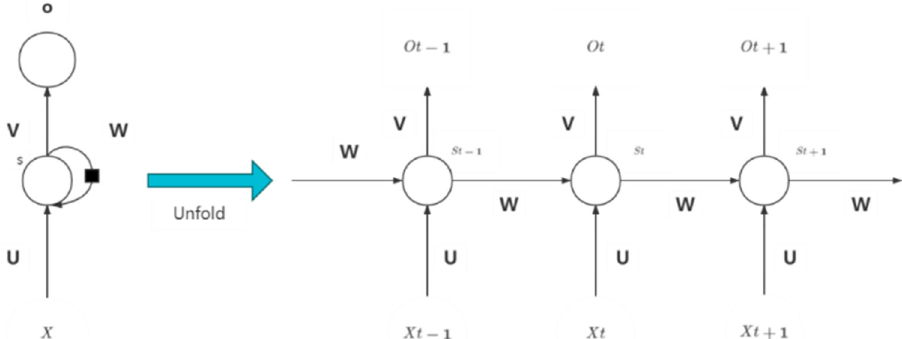
Figure 5. Internal structure of the hidden layer.